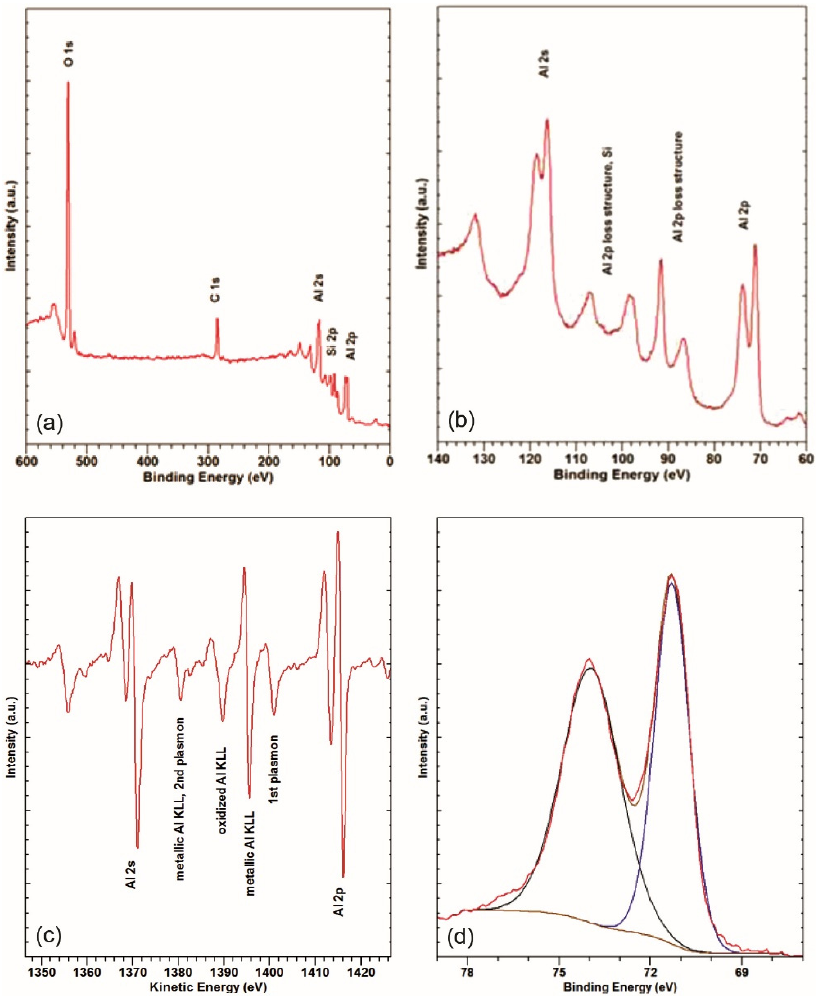
Figure 4. XPS survey spectrum ( a ), narrow-range 60–140 eV region ( b ), differentiated XPS spectrum from the 60–140 eV region ( c ), and narrow-range Al 2p ( d ) measured on the freshly cut surface. The survey spectrum of the freshly cut surface in Figure 4a shows strong Al 2p, Al 2s, C 1s, and O 1s peaks. Ca 2p and Ar 2p do not appear, since this surface was exposed to the atmosphere for a short time (minutes) and was not ion-etched. Unlike the measure- ments on the degraded and undegraded surfaces where Mg K α at 1256.7 eV was used for the XPS, Al K α at 1487.6 eV was used instead. This was to enable the Auger transition in the Al KLL at approximately 1395 eV of kinetic energy (KE) to be observed in the XPS spectrum. This corresponds to approximately 92 eV on the BE scale. In Figure 4b, the BE region between 60 and 140 eV measured at higher resolution is shown. A strong Al 2p plasmon-loss structure is observed [39,40], as expected for a metallic surface. This points to a rather large, unoxidized share of the surface, or rather, to extremely thin Al (of the order of nm) oxide/hydroxide layers in the analysed area, since the intensity of the plas- mon-loss structure tends to increase with the metallicity [39,40]. This loss structure over- laps with the Al KLL Auger transition and the Si 2p peak. A differentiated spectrum of the 60–140 eV BE region is shown in Figure 4c. Here, the kinetic-energy scale is used. The spectrum was differentiated to better elucidate the Al KLL Auger transition structure and facilitate its comparison with the reference data [38,39,41]. A strong peak at 1395 eV of KE is observed. This corresponds to the Al KLL main peak for metallic Al [38,39,41]. There is also a peak of lower intensity at 1389 eV of KE , which corresponds to Al in oxide/hydrox- ide compounds [21,22,37]. The peak at 1380 eV of KE corresponds to the second plasmon in the Al 2p loss structure on the BE scale (105 eV). The intensity of the peak, however